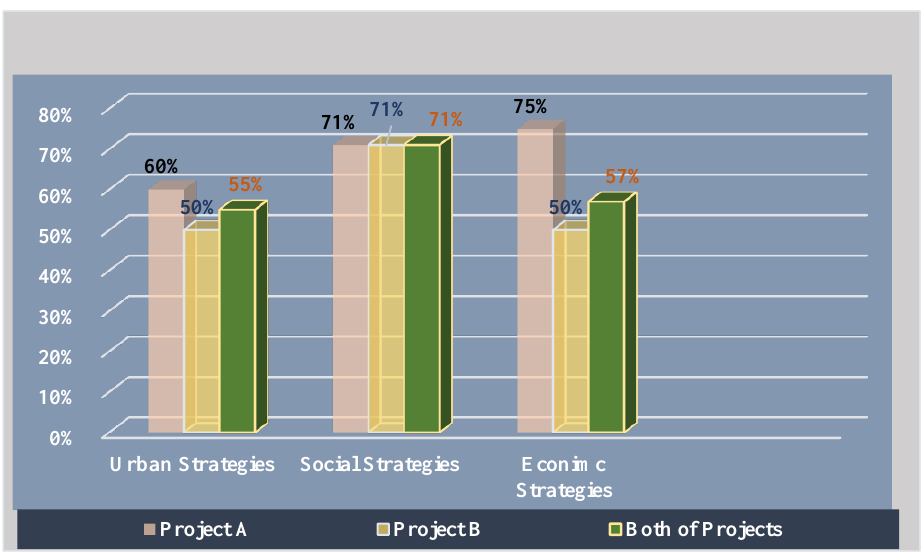
Figure 15. Results of the three items considered in the practical study.